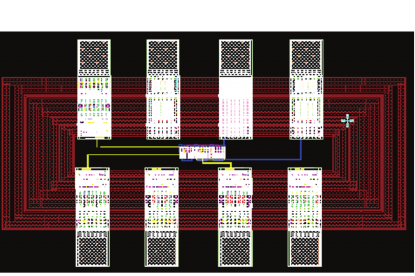
Figure 8: Layout of the pseudodifferential